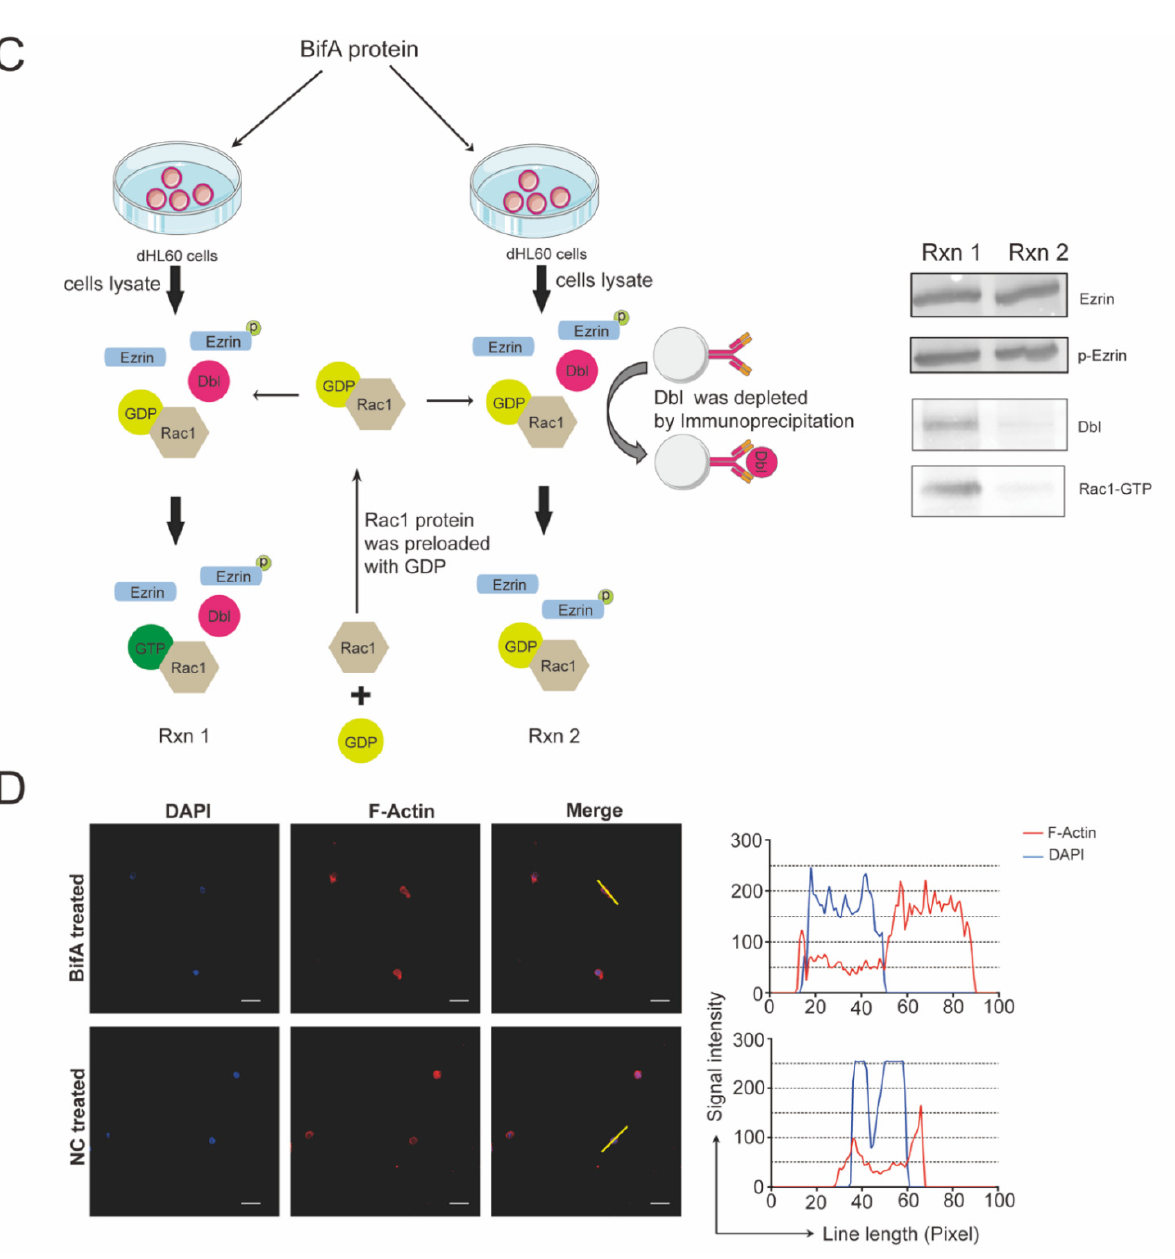
Figure 3. Rac1-GTP formation increased in BifA-treated dHL60 cells due to p-ezrin recruited Dbl. ( A ) Western blots were performed on lysates of dHL60 cells after BifA treatment. Total Rac1 and rhotekin protein precipitated GTP-bound Rac1 were detected with anti-Rac1 antibody. The graph shown below is normalized grayscale intensity analyses (measured with ImageJ software). ( B ) BifA- treated dHL60 cell lysate (input) was used to CO-IP with p-ezrin conjugated beads. Western blots were performed to detect the existence of Dbl and p-ezrin in the elution. ( C ) The dHL60 cell lysate was used as reaction system 1 (Rxn 1). Reaction system 2 (Rxn 2) was Dbl depleted dHL60 cell lysate generated with anti-Dbl antibody-conjugated beads for depletion. Ezrin, p-ezrin, Dbl in Rxn 1 and 2 were detected with immunoblot directly. The amount of Rho-GTP was measured by a pull-down method based on its specific binding to Rhotekin-RBD followed by immunoblot with an anti-Rac1 antibody. ( D ) Immunofluorescent staining of F-actin in dHL60 cells was observed by confocal microscopy. (Bar = 20 µ m). The optical density of the scribed line in the picture was measured with Image